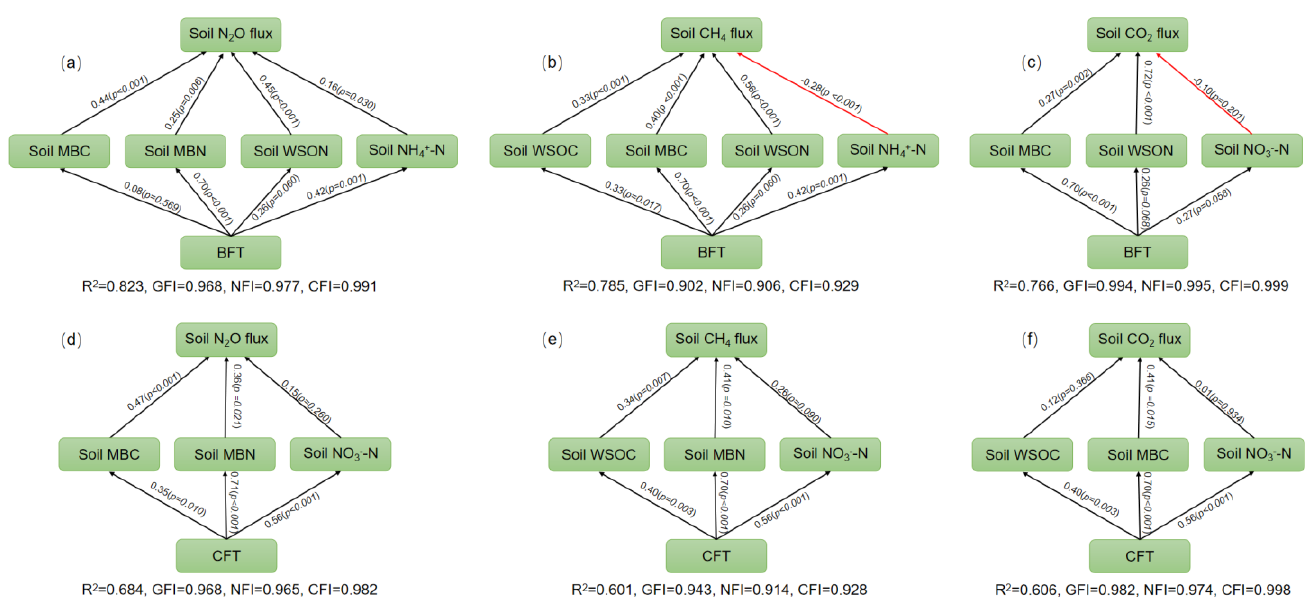
Figure 8. Structural equation modeling illustrating the impacts of soil MBC, WSOC, NO 3 − -N, NH 4+ -N, WSON, and MBN concentration on ( a , d ) soil N 2 O emission, ( b , e ) CH 4 uptake, and ( c , f ) CO 2 emission after applying biochar-based fertilizer treatment (BFT) and chemical fertilizer treatment (CFT). The numbers next to the arrows denote the correlation coefficient and statistical significance. R 2 denotes the percentage of variance revealed by SEM, GFI denotes the goodness of fit index, NFI denotes the normed fit index, and CFTI denotes the comparative fit index. Black and red lines denote positive and negative relationships, respectively.